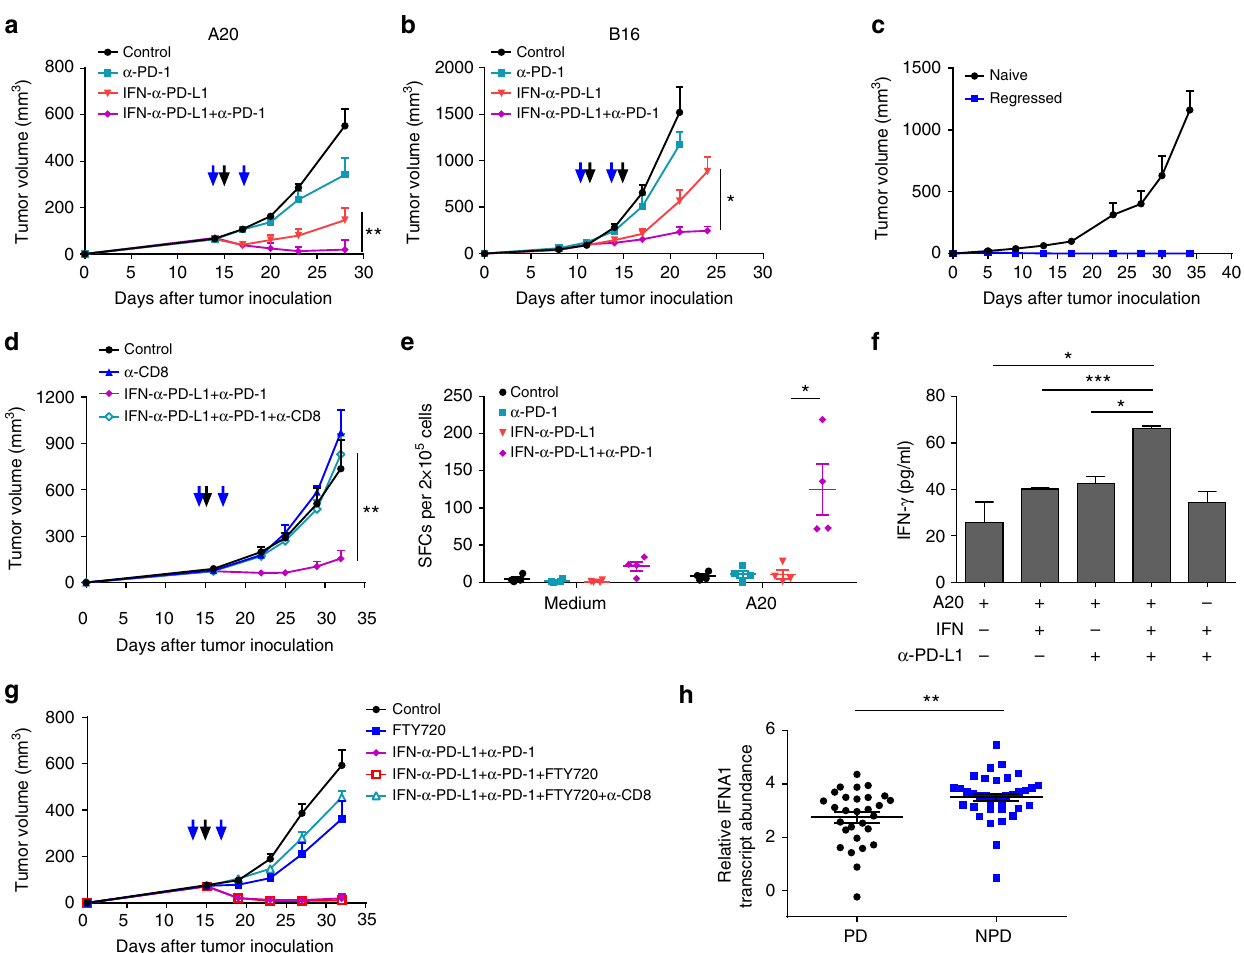
Fig. 6 PD-1 blockade further ensures that IFN α -anti-PD-L1 induces feedforward antitumor responses. a A20 tumor-bearing Balb/c mice ( n = 4 – 5) were treated with 20 µ g of IFN α -anti-PD-L1 on day 15 and/or 100 µ g anti-PD-1 on days 14 and 17. Tumor growth was measured twice per week. b B16 tumor- bearing C57BL/6 mice ( n = 3 – 5) were treated with 25 µ g of IFN α -anti-PD-L1 on days 11 and 14 and/or 100 µ g of anti-PD-1 on days 12 and 15. Tumor growth was measured twice per week. c Mice ( n = 4) with complete regression after combination therapy in a were re-challenged with 2.5 × 10 7 A20 cells. Naive mice inoculated with A20 cells were used as a control. Tumor growth was measured twice per week. d Mice ( n = 4) were treated with IFN α -anti-PD-L1 and anti-PD-1 as in a . For cell depletion, mice were injected with 200 μ g of anti-CD8 antibody from 1 day before anti-PD-1 treatment. Tumor growth was measured twice per week. e Mice were treated with IFN α -anti-PD-L1 and/or anti-PD-1 as in a . Twelve days after treatment, tumor-draining LNs were isolated and single-cell suspensions were prepared. Cells were co-cultured with or without irradiated A20. The IFN γ ELISPOT assay was performed. f Tumor-in fi ltrating DC (CD11c + ) and T (CD8 + ) cells were isolated from A20 tumor-bearing mice and co-cultured in the presence of irradiated A20 cells. IFN α -Fc or anti-PD-L1 was added to the culture medium. Three days later, supernatants were harvested and IFN γ levels were measured by CBA. g A20 tumor-bearing mice ( n = 5 – 6) were treated with IFN α -anti-PD-L1 and/or anti-PD-1 as in a . FTY720 was administered every other day from day 14. To deplete intratumoral CD8 + T cells, 30 µ g anti-CD8 antibody was injected i.t. on days 14 and 17. Tumor growth was measured twice per week. Blue and black arrows indicate treatment with anti-PD-1 and IFN α -anti-PD-L1, respectively. h Patients treated with anti-PD-1 antibody were grouped as progressive disease (PD, n = 29) or non-progressive disease (NPD, n = 36). Relative IFNA1 transcript abundances were compared. Data indicate mean ± SEM and are representative of at least two independent experiments. * p < 0.05; ** p < 0.01; *** p <